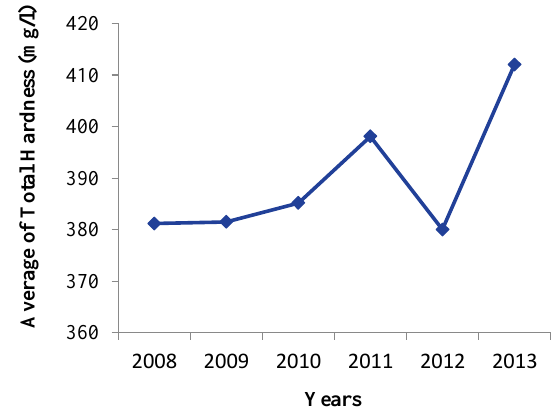
Total Hardness Mean, minimum, maximum and standard